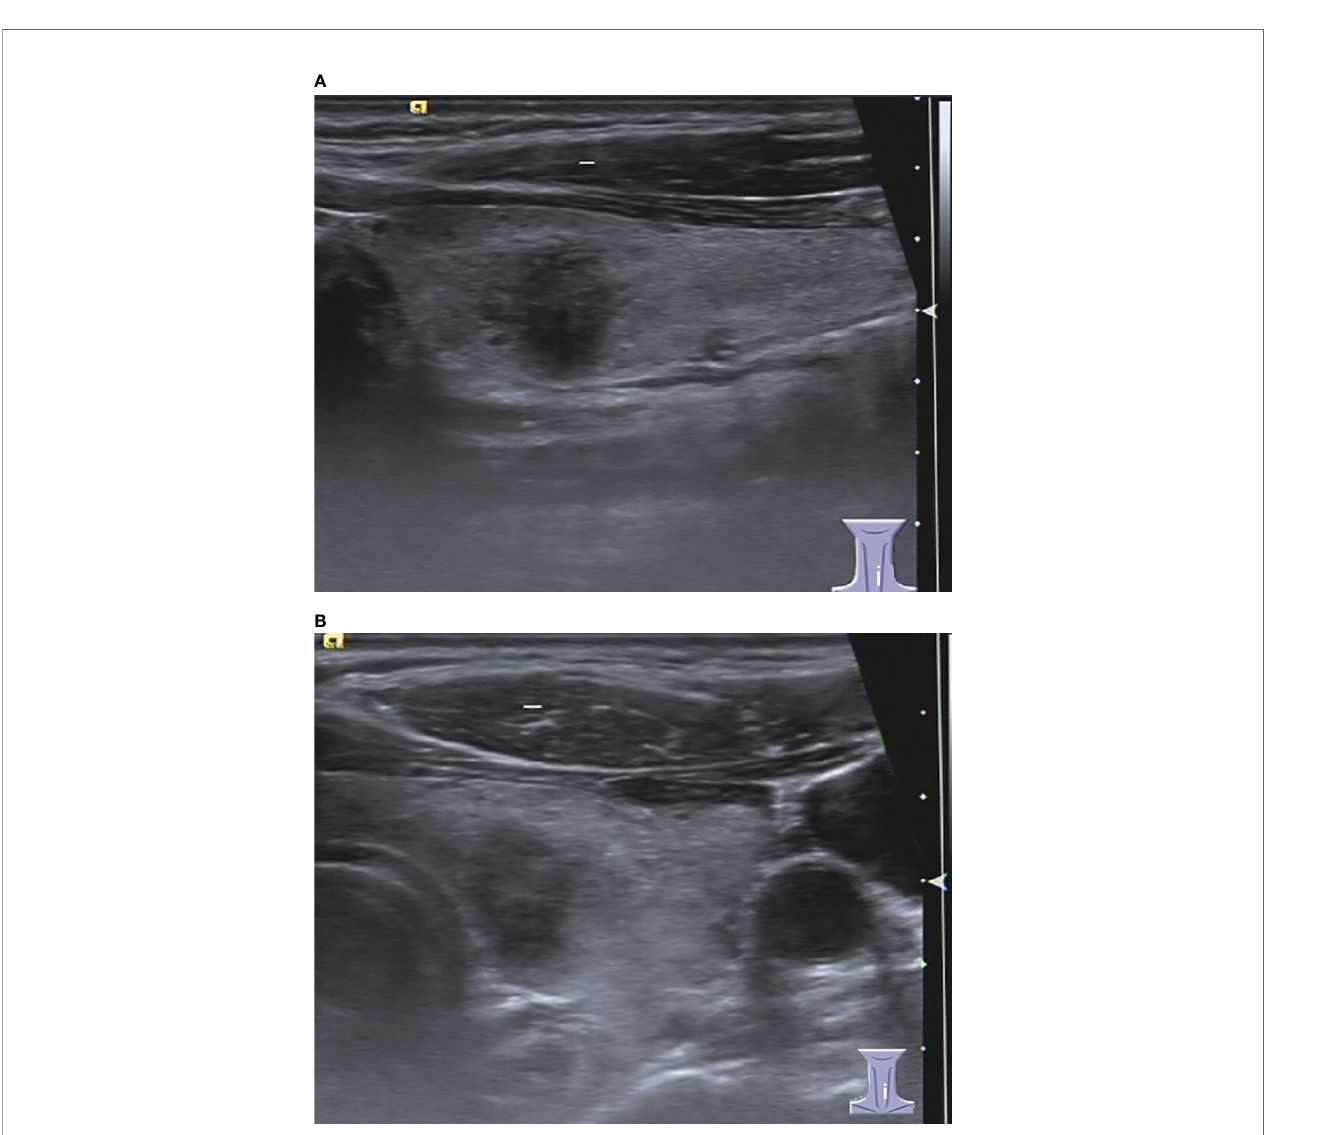
FIGURE 5 | 37-year-old woman with chronic lymphocytic thyroiditis. Sonographies of longitudinal scanning (A) and axial scanning (B) show the nodule locates at the left lobe of the thyroid, characterized by 9.8mm×9.2mm×9.4mm in size, solid composition, irregular shape, A>T orientation, hypoechoic, ill-de fi ned margin, and absence of posterior acoustic effect. C-TIRADS 4C, K-TIRADS 5, ACR-TIRADS 5. Histopathology con fi rmed it is a chronic lymphocytic